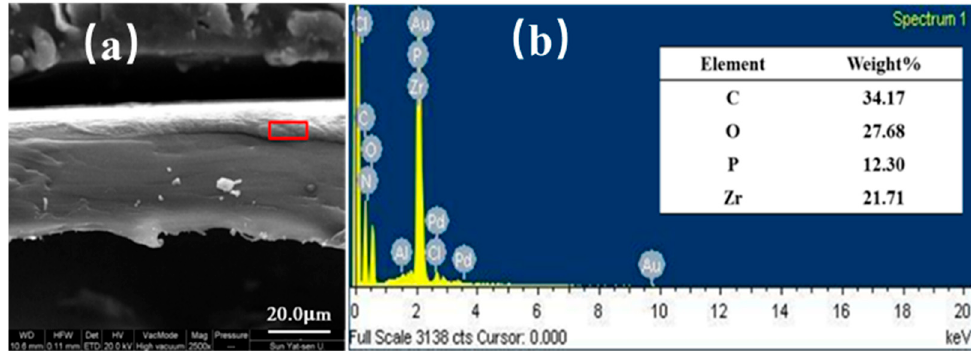
Figure 7. Cross sectional SEM image ( a ) and EDS result of polyethylene terephthalate quadlayer ((PET-(QL)) 11 .